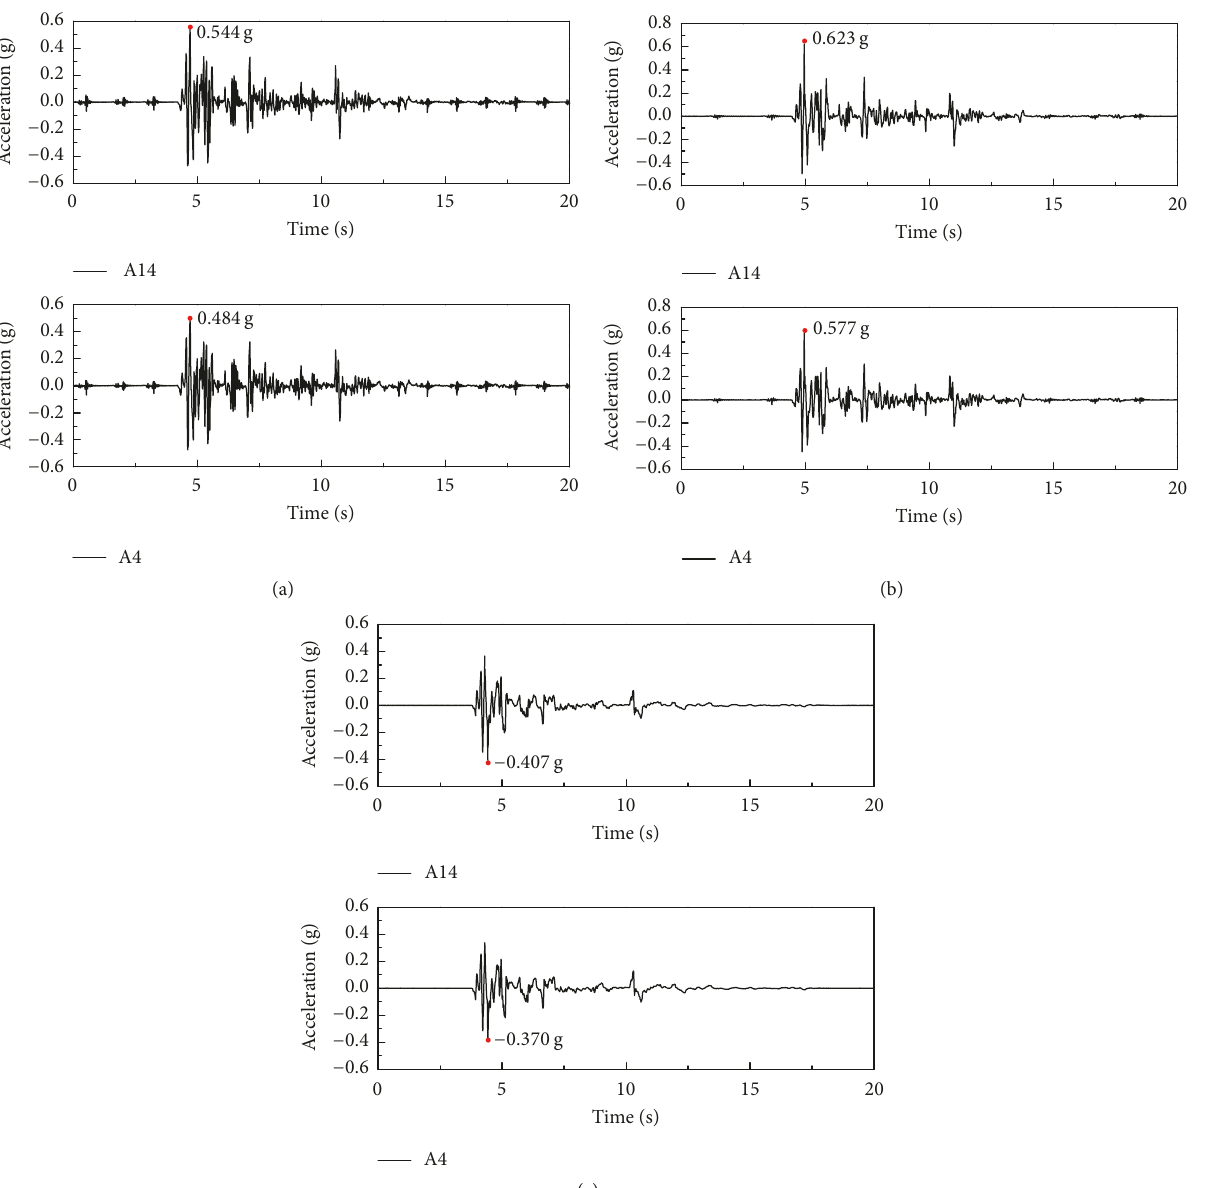
Figure 9: Comparison of acceleration obtained from A4 and A14 during the testing; acceleration time histories of (a) test 1, (b) test 2, and (c) test 3.